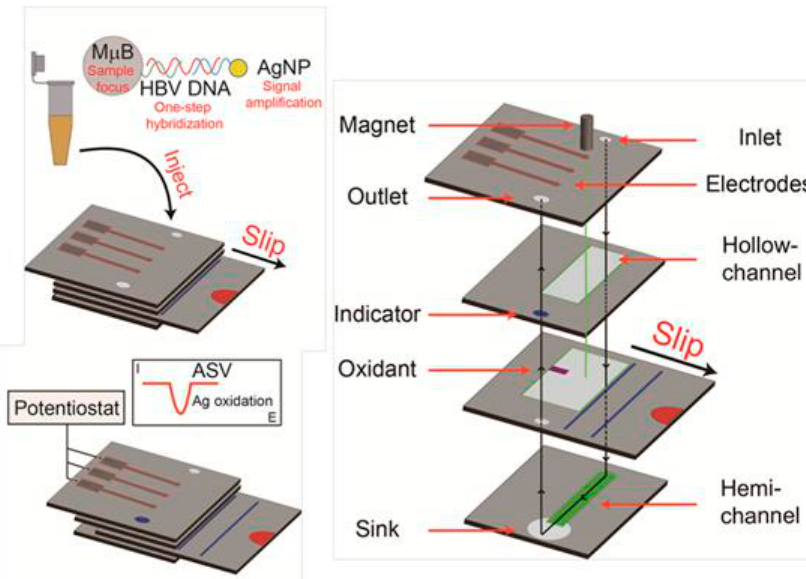
Figure 11. Schematic illustration of the development of paper-based biosensor the detection of DNA sequence from the hepatitis B virus, applying AgNP labeling and MBs as capture probes. Reproduced from [32], with permission from American Chemical Society, 2019.